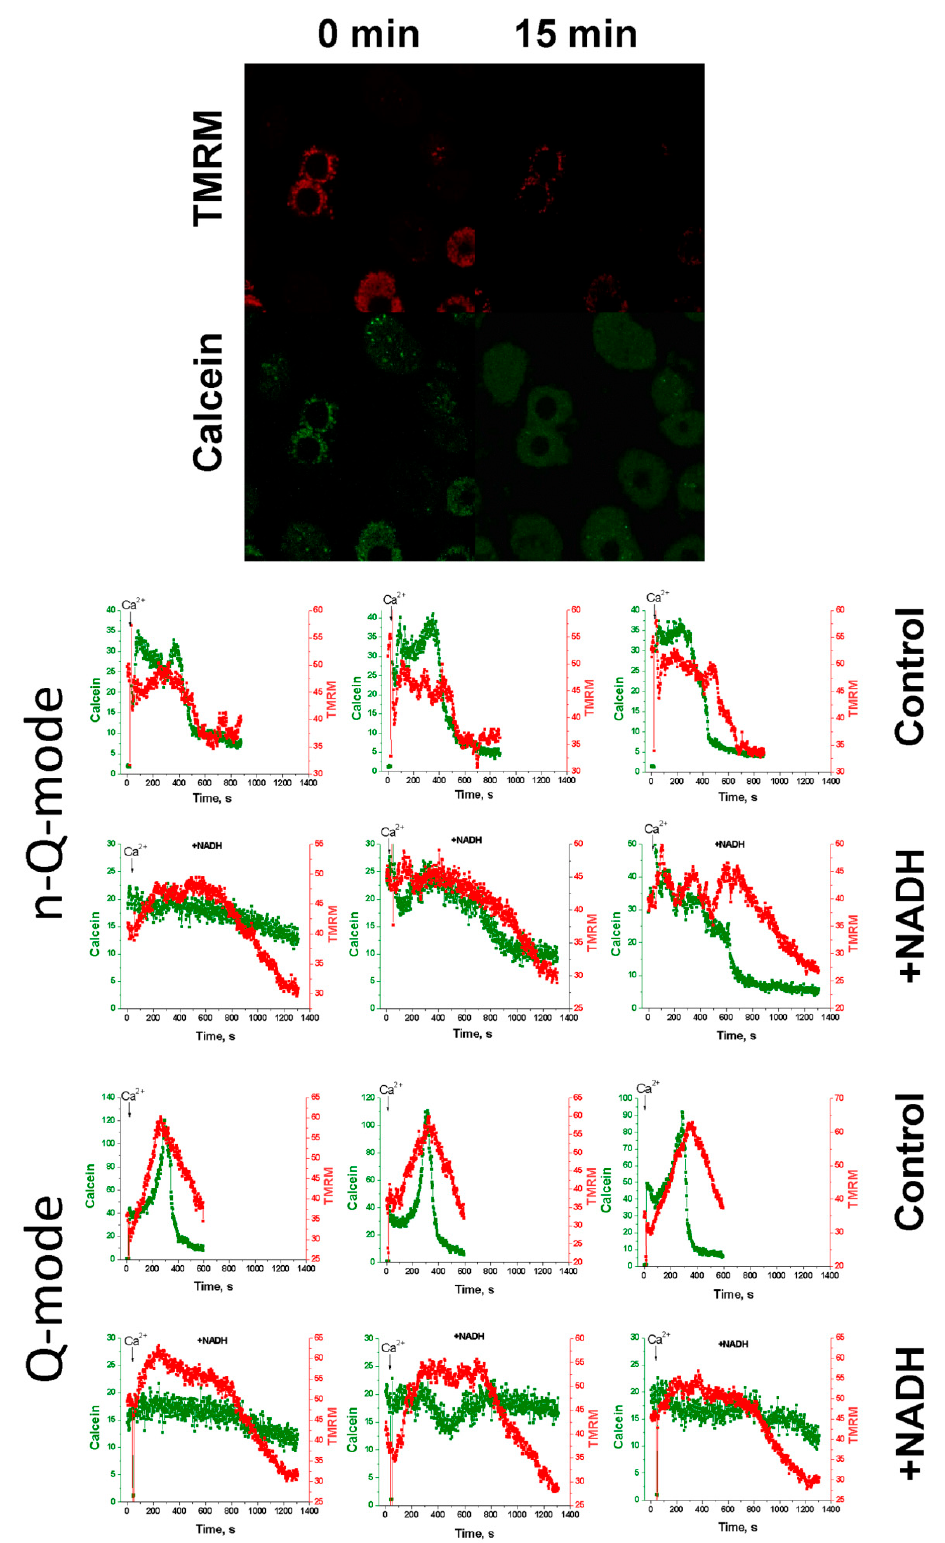
Figure 5. Effect of NADH on the Ca 2+ -induced loss of ∆Ψ m and calcein release from individual mitochondria. Isolated rat hepatocytes were stained with 5 µ M calcein-AM and 100 (n-Q-mode) and 300 nM (Q-mode) TMRM. The cell incubation medium was replaced by mitochondria-supporting medium (125 mM KCl, 20 mM sucrose, 10 mM HEPES (pH 7.3), 5 mM succinate, 2.5 µ g/mL rotenone, and 40 µ M digitonin) supplemented, where indicated, with 2 mM NADH two minutes before the addition of 50 µ M Ca 2+ . Representative traces of the dynamics of TMRM (red) and calcein fluorescence (green) in 12 selected mitochondria of 180 total from three separate experiments are